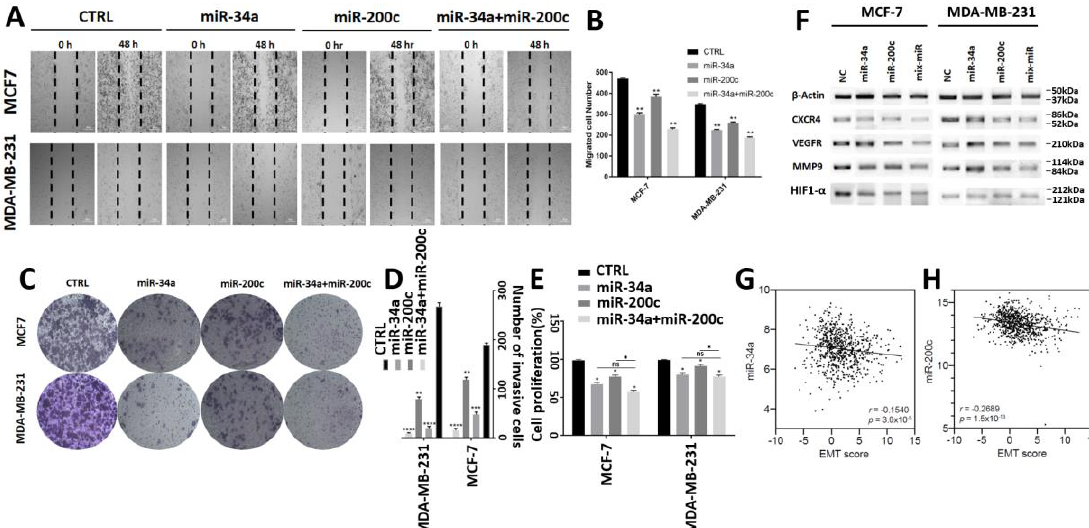
Figure 3. MiR-34a and miR200c additionally suppress breast cancer cell migration, invasion, proliferation and expression of markers for the epithelial-to-mesenchymal transition. ( A ) Light microscope images showing the migration of indicated cells in scratch “wound” assays. Scratch areas are marked by hatched lines. Images show timepoints 0 and 48 h (h) after application of the scratches. Cells were transfected with indicated miRNAs. ( B ) Quantification of the numbers of cells that migrated into the scratch areas after 48 h, as shown in ( A ). **, p -value < 0.01. ( C ) Images of invasion assay plates of transfected breast cancer cell lines, as indicated. ( D ) Quantification of cell invasion in transfected cells, as shown in ( C ). **, p -value < 0.01; ***, p -value < 0.001; ****, p -value < 0.0001. ( E ) Quantification of BC cell proliferation relative to control transfected cells. ( F ) Western blots showing changes in expression levels of EMT-promoting proteins after miRNA transfection. ( G , H ) Correlations between an EMT score and miR-34a or miR200c expression, respectively, in breast tumors (each n = 729). Data are derived from TCGA and show the Spearman’s rank correlation coefficients and p values. Abbreviations: CTRL: control; *, p -value <